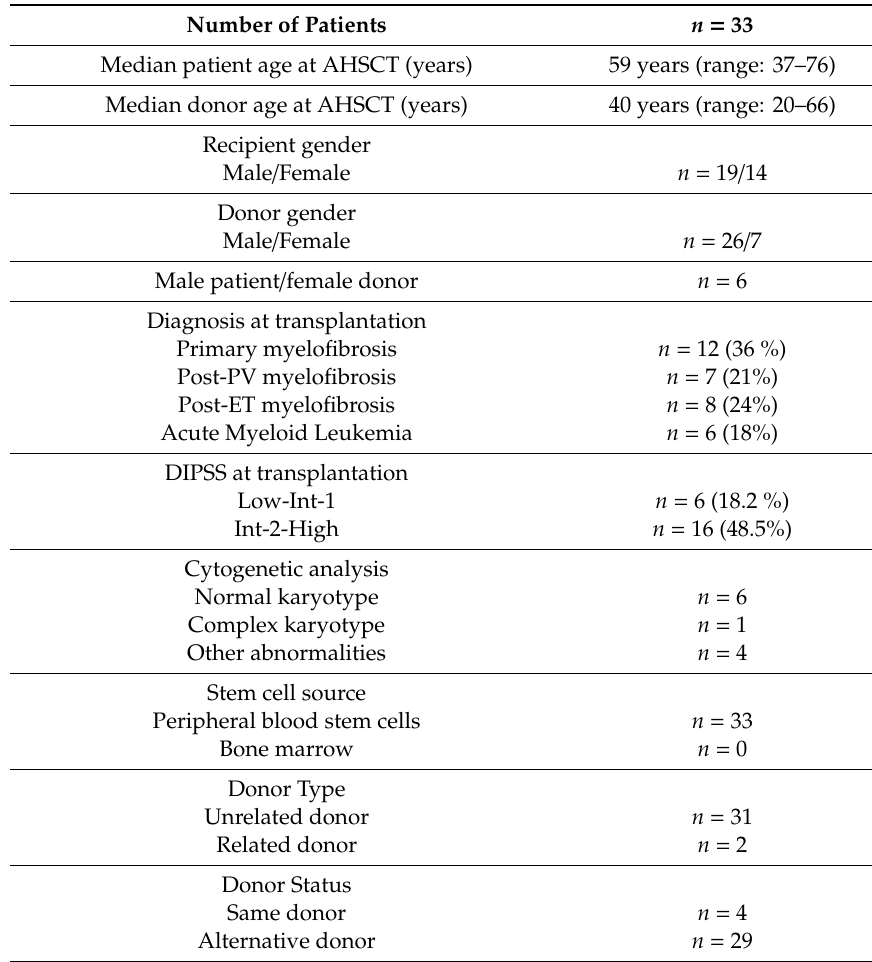
Table 1. Patient